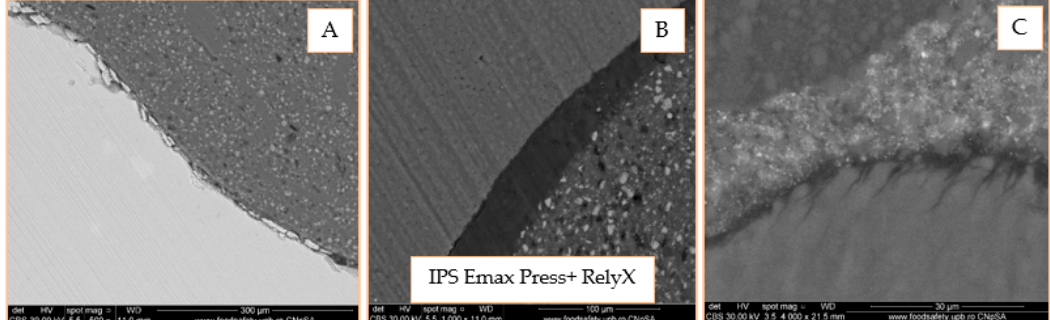
Figure 19. Adhesive coating interface, 500× ( A ); SEM 1000× image of the tooth area (dentin)—adhesive—adhesive cement ( B ); Adhesive-adhesive-enamel cement area, 4000× ( C ).